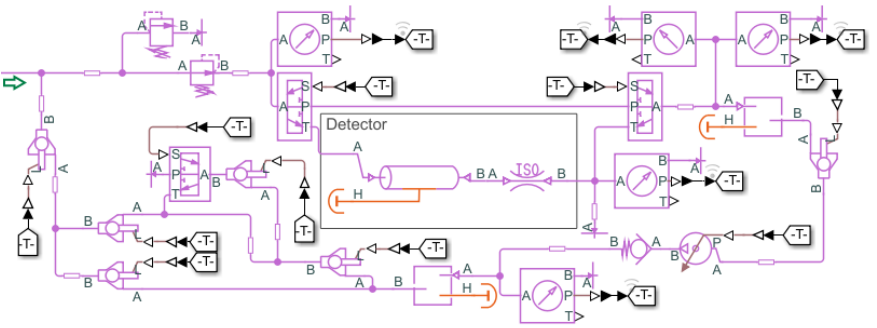
Figure 6. The simulation model of the recirculation subsystem.